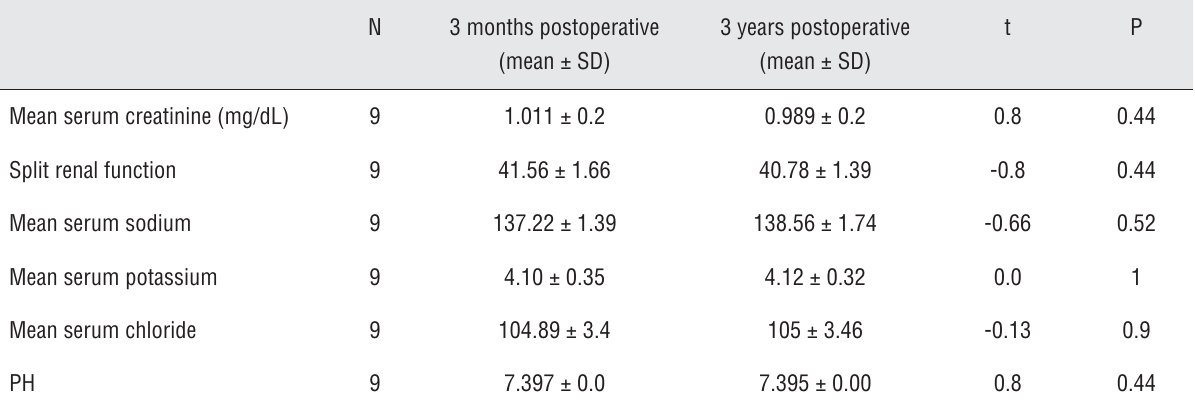
Table 2 - 3 months and 3 years postoperative results of laboratory investigations and split renal function.